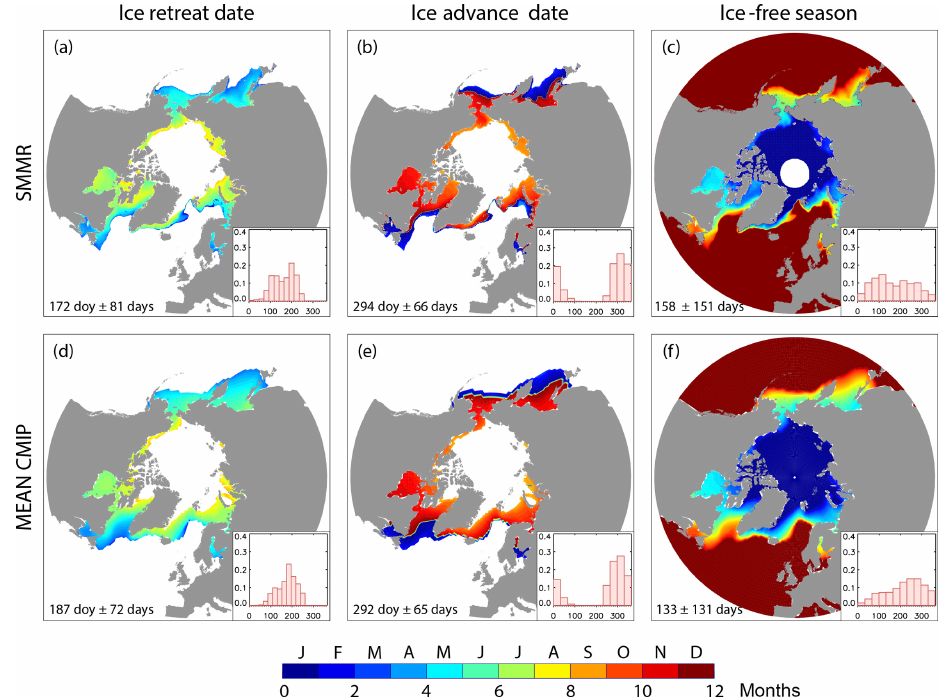
Figure 2. Maps and frequency histograms of (a, d) ice retreat date, (b, e) ice advance date and (c, f) ice-free season length over 1980– 2015 (36 years), based on (a, b, c) passive microwave satellite concentration retrievals (Comiso, 2000; updated 2015) and (d, e, f) daily concentration fields averaged over CMIP5 models. Median ± IQR (interquartile range) refers to all points in the seasonal ice zone. See Fig. S3 for individual